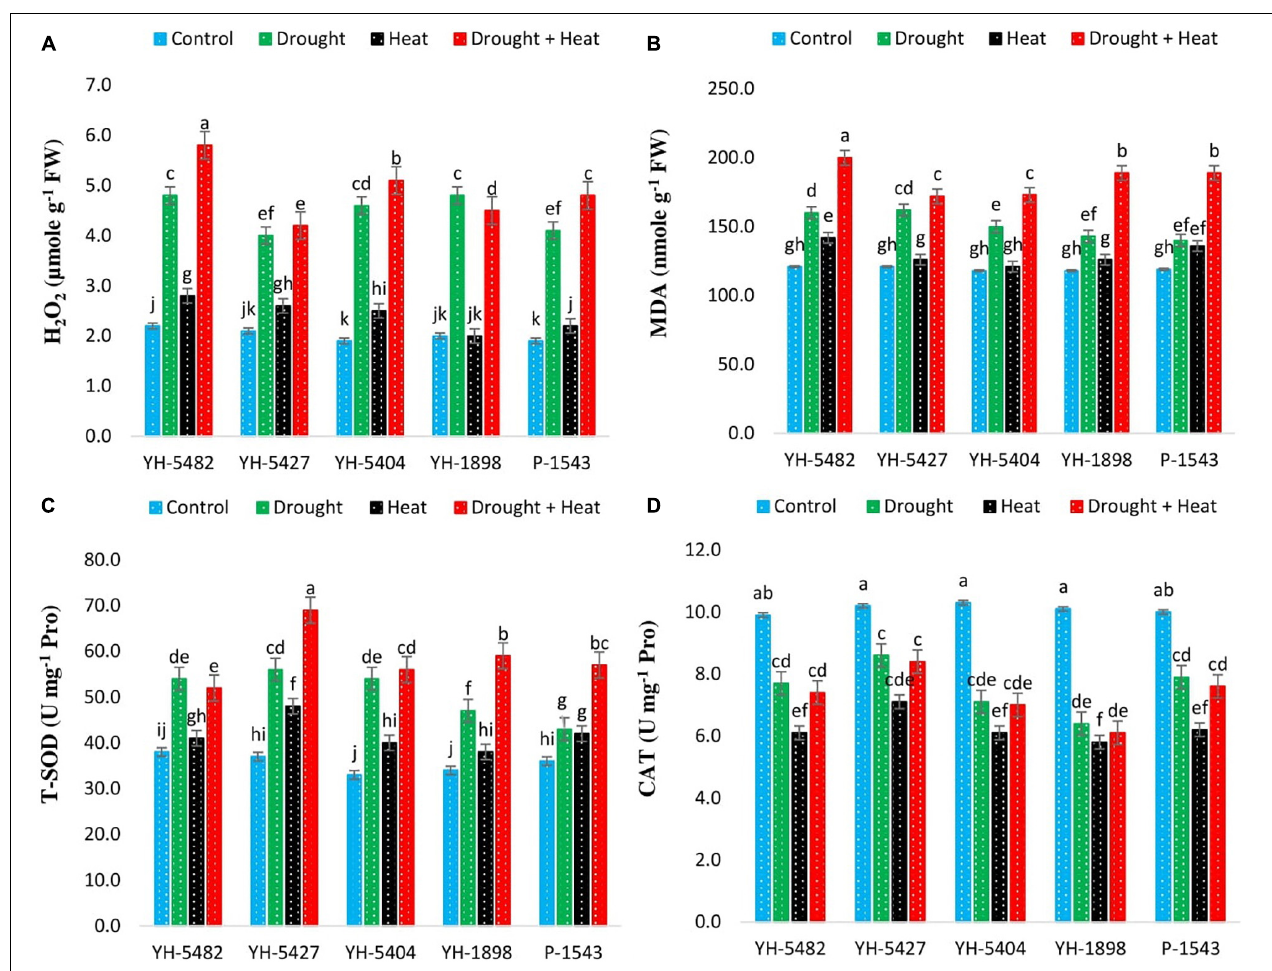
FIGURE 6 | Effect of heat, drought, and heat +drought stress on (A) H 2 O 2 (B) MDA (C) T-SOD and (D) CAT in five maize hybrids. Capped bars above means represent the ± SE of three